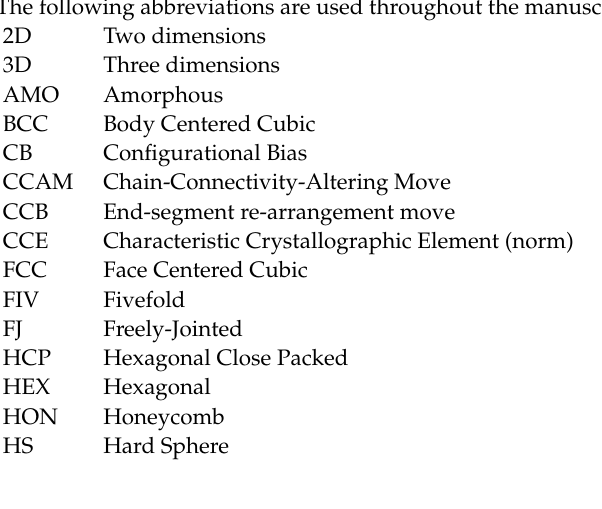
Figure S3: Exponential moving average of the orientational order parameter, q , as a function of MC steps for 100-chains N av = 12 semi-flexible system with bending constant and equilibrium bending angle θ 0 = 0 ◦ at different packing densities, ϕ ; Figure S4: Final configuration for the 100-chains N av = 12 semi-flexible system chains with bending constant k θ = 9 and equilibrium bending angle θ 0 = 0 ◦ at ϕ = 0.58 and 0.60; Figure S5: Degree of crystallinity, τ c , as a function of MC steps at different packing densities, ϕ